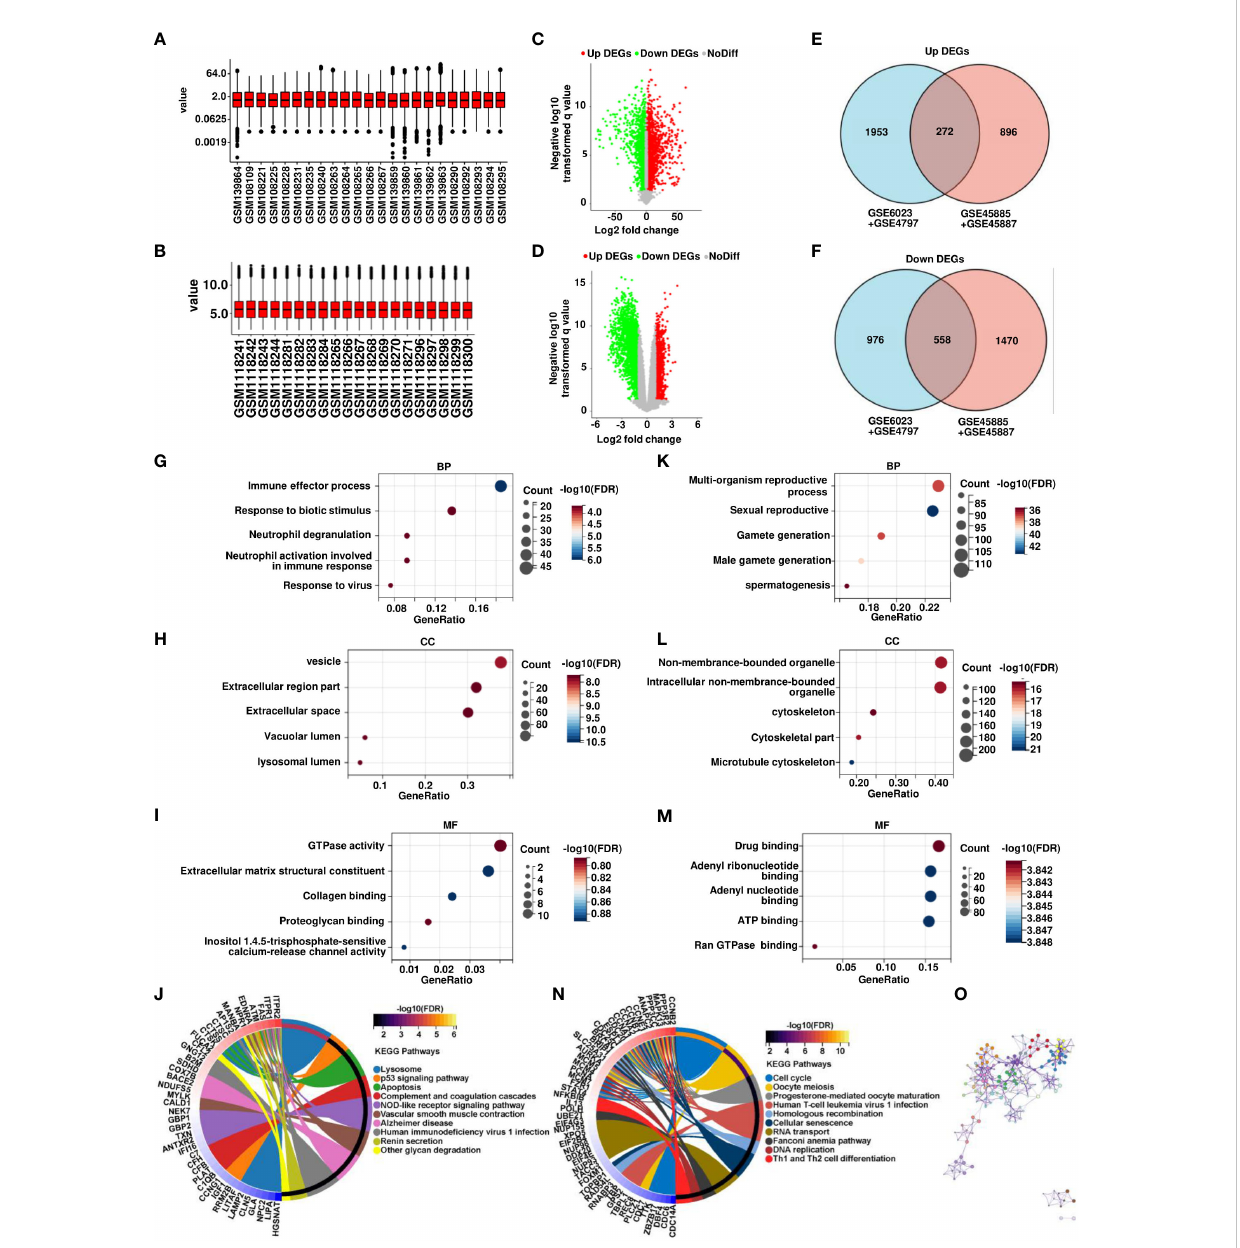
FIGURE 1 Analysis of transcriptomic pro fi les of OA and SCOS samples. (A) Expression data normalization in GSE6023 and GSE4797. (B) Expression data normalization in GSE45885 and GSE45887. (C, D) Volcano map of signi fi cant differential genes between SCOS and OA samples in GSE6023 and GSE4797 as well as GSE45885 and GSE45887. (E, F) Wayne plots of overlapping candidate genes were up- and downregulated in both combined datasets. Gene ontology (GO) analysis of (GK) biological process (BP), (H, L) cellular component (CC), (I, M) molecular function (MF), and (J, N) Kyoto encyclopedia of genes and genomes enrichment of up- and downregulated differential genes. (O) Construction of differential gene PPI networks based on STRING